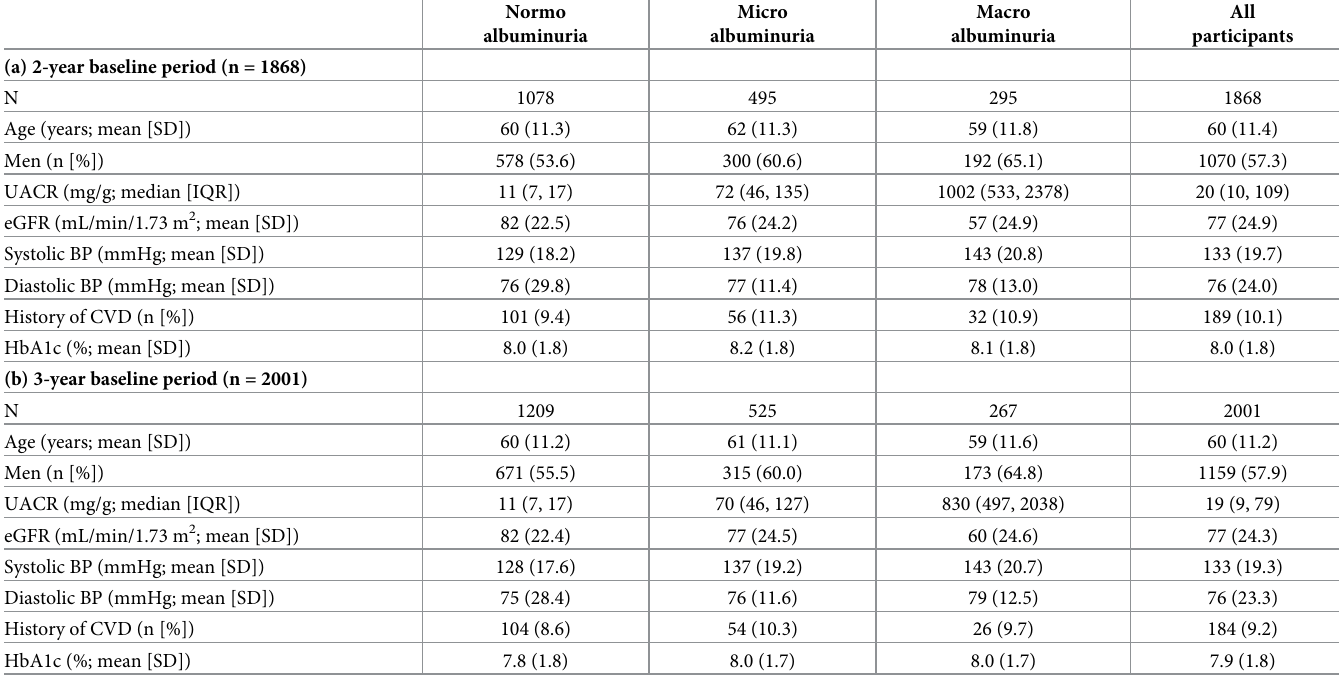
UACR, urine albumin-to-creatinine ratio; eGFR, estimated glomerular filtration rate; BP, blood pressure; CVD, cardiovascular disease; SD, standard deviation; IQR, interquartile